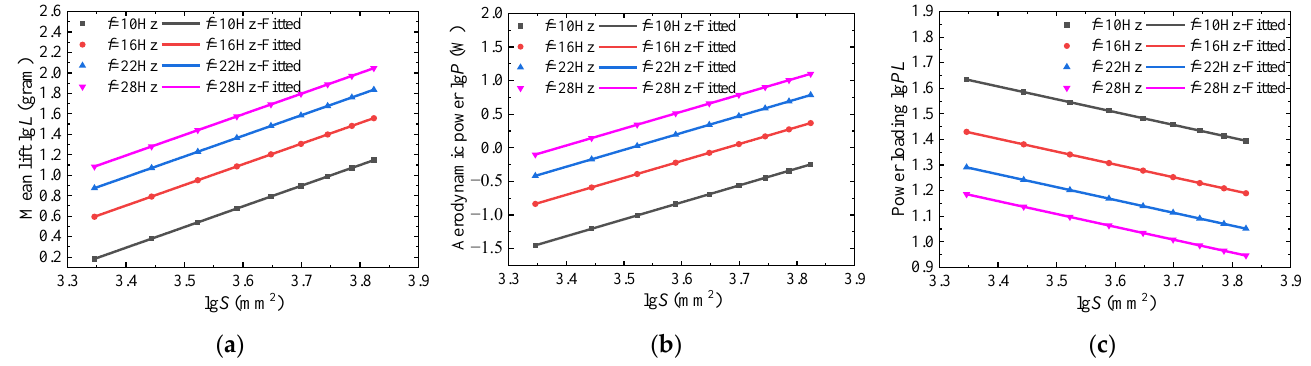
Figure 8. Logarithmic relationship of aerodynamic performance with S . Symbols are raw data, and solid lines are fitted data. ( a ) Mean lift with S . ( b ) Aerodynamic power with S . ( c ) Power loading with S . Table 6. Coefficients for the power relationship between aerodynamic performance and S at differ- ent flapping frequencies.